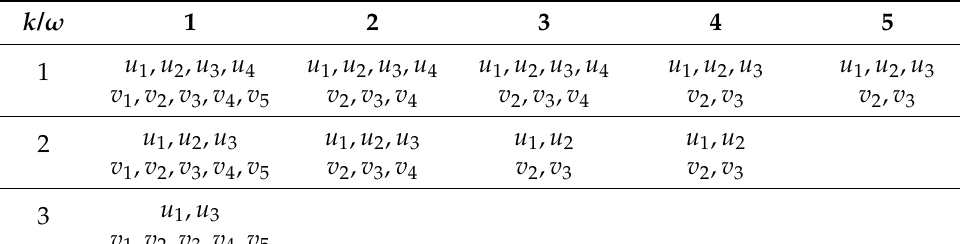
Table 1. Index construction